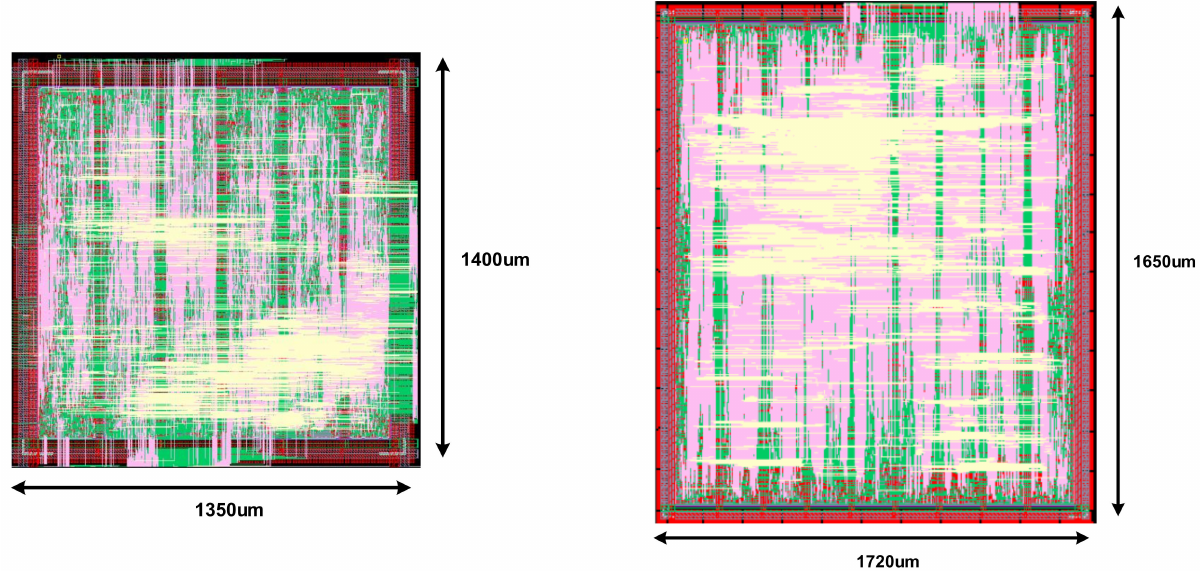
Figure 8. The layout of the controller of the CNN: ( a ) AISSC layout; ( b ) AINC